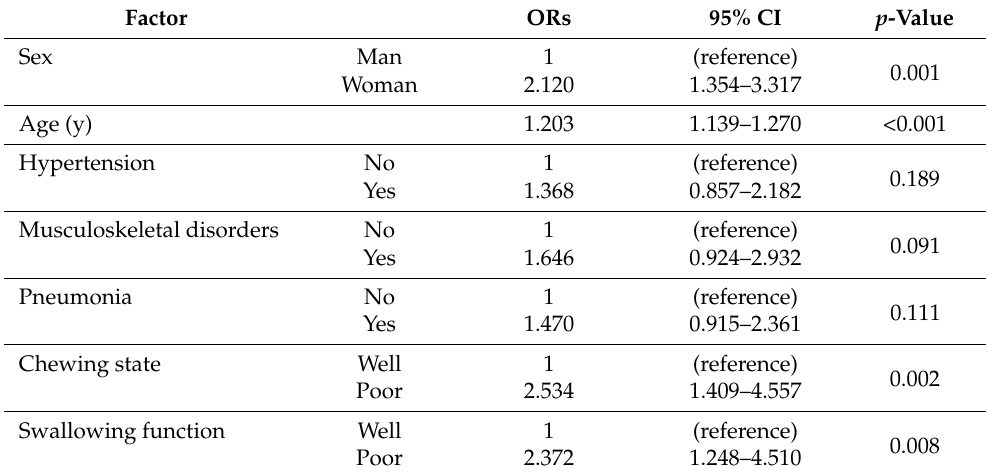
Table 4. Adjusted odds ratios and 95% CIs for support/care-need certification at follow